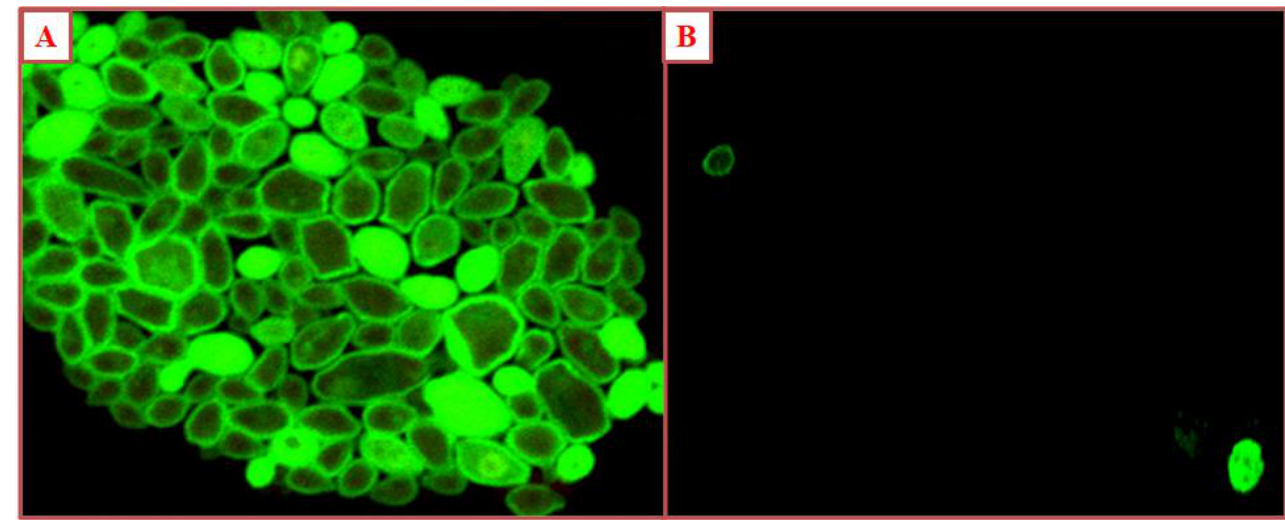
Figure 7. TEM image of C. albicans treated with CS-AgNPs at 500 µg/mL. Black arrows indicate CS-AgNPs at the surface, whereas red arrows indicate the internalization of CS-AgNPs.